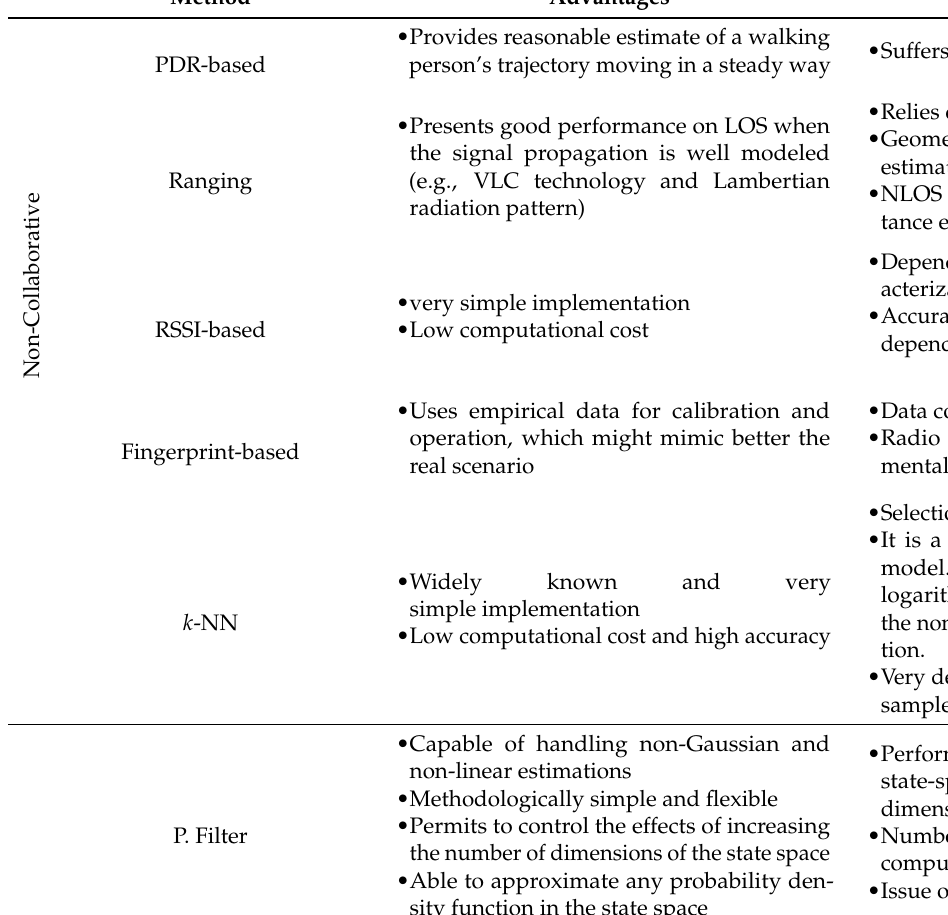
Table 5. Summary of advantages and disadvantages of the most used non-collaborative and collaborative methods. The top section presents the five most used non-collaborative methods. The bottom section presents the six most used collaborative